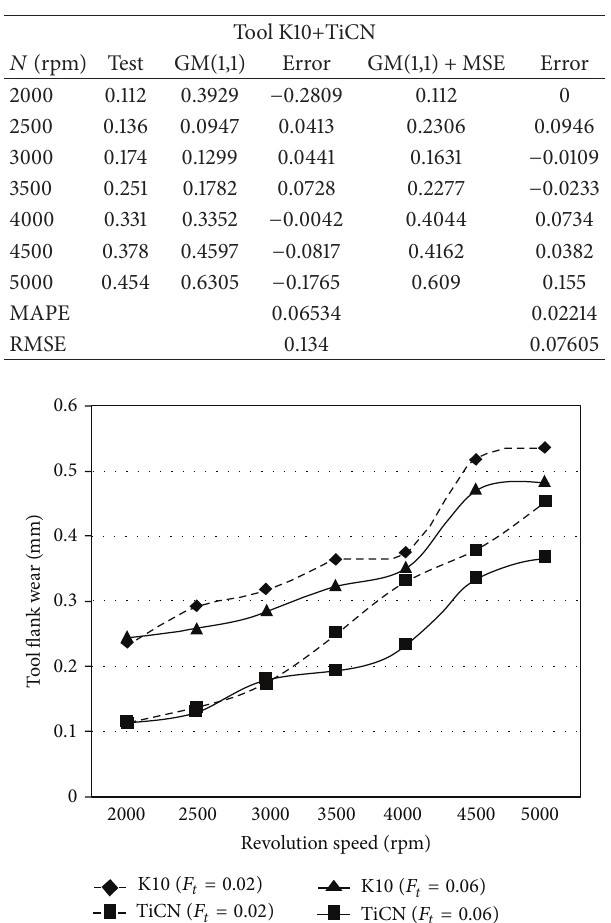
Table 3: Comparison sheet of the common and improved grey prediction model.